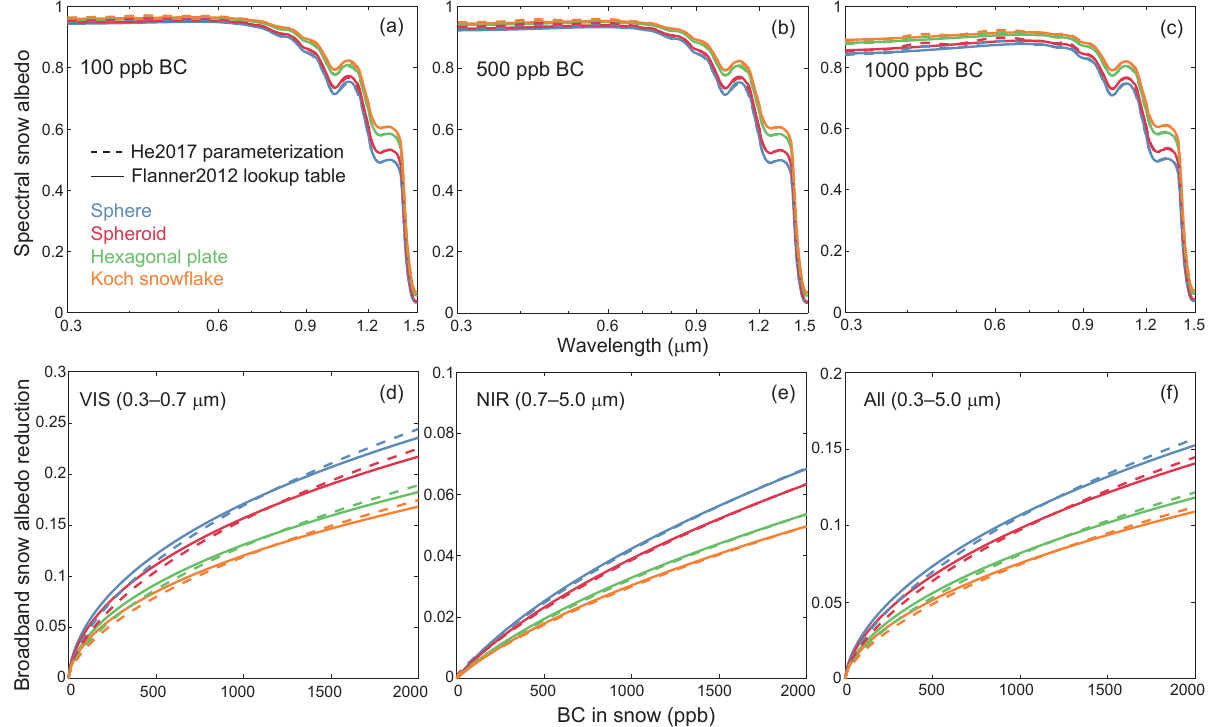
Figure 5. Comparisons of SNICAR simulated direct-beam albedo of semi-infinite snow layers between using the Flanner et al. (2012) lookup table (solid lines) and the He et al. (2017b) parameterization (dashed lines) for BC internally mixed with snow grains with an effective radius of 100µm for sphere (blue), spheroid (red), hexagonal plate (green), and Koch snowflake (orange). (a–c) Spectral (0.3–1.5µm) snow albedo for BC concentrations of (a) 100, (b) 500, and (c) 1000ppb. (d–f) Broadband snow albedo reduction as a function of BC concentration in snow at (d) visible (VIS, 0.3–0.7µm), (e) near-infrared (NIR, 0.7–5µm), and (f) all (0.3–5µm) wavelengths. The results for snow effective radii of 500 and 1000µm are shown in Figs. S5 and S6 in the Supplement,